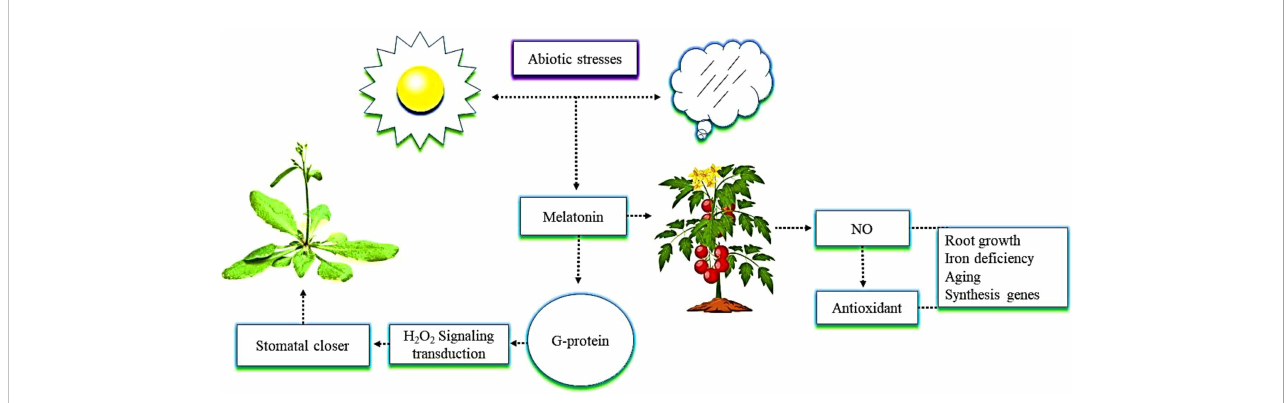
FIGURE 3 The interactive role of melatonin with nitric oxide (NO) in mitigating abiotic stress. The application of melatonin in tomato plants enhances NO content. NO further triggers antioxidant enzymes activity in plants, which shows resistance to abiotic stress and enhances root growth, iron de fi ciency, aging, and the expression of synthesis genes. In addition, G protein as a melatonin receptor mediates hydrogen peroxide (H 2 O 2 ) signaling transduction that is involved in a melatonin-induced stomatal closure in Arabidopsis .